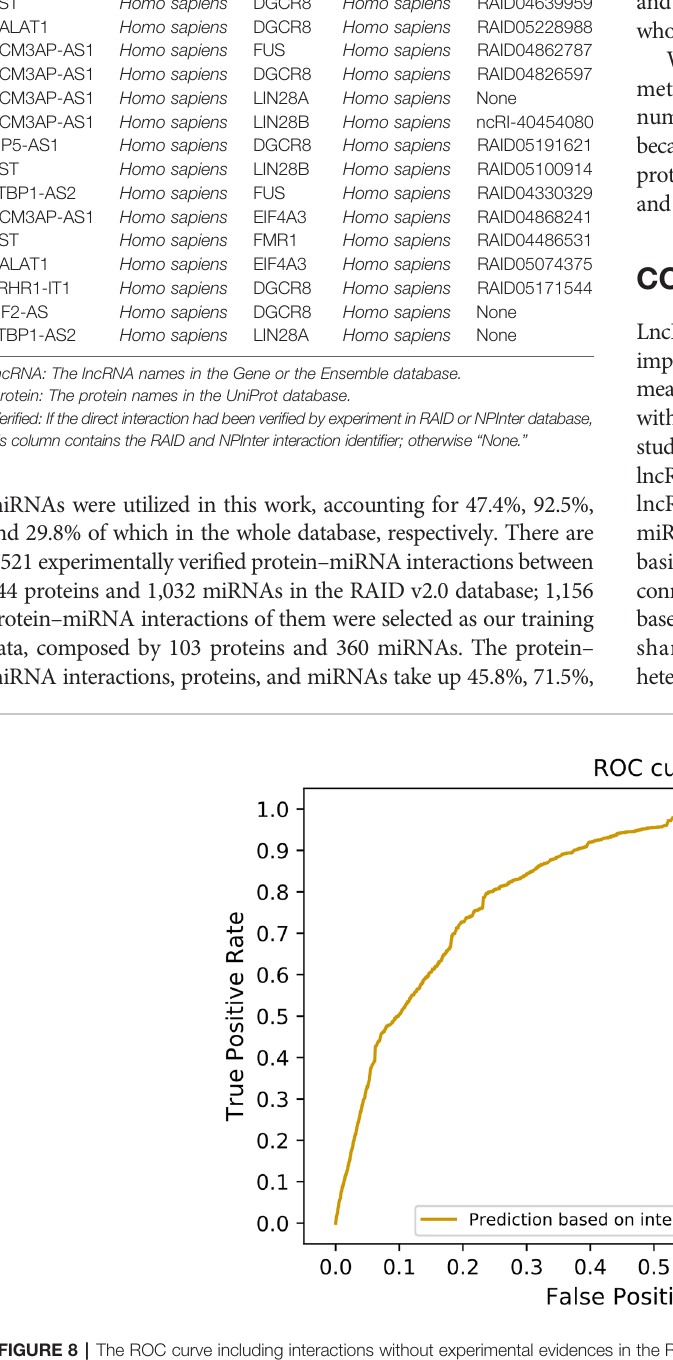
FIGURE 8 | The ROC curve including interactions without experimental evidences in the RAID v2.0 database. In other words, interactions of the whole RAID database were utilized to train our model. The network similarity of both lncRNAs and proteins were selected to generate our fi nal scoring matrix, which preformed the best in former experiment.